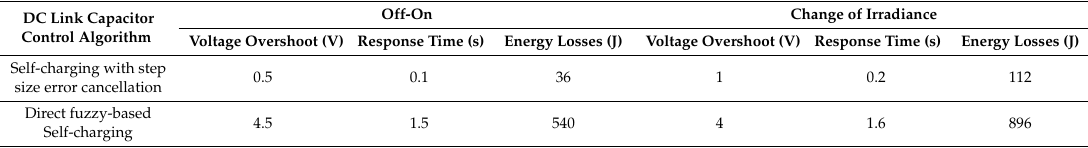
Table 4. Overall performance of DC link capacitor voltage control algorithms for both dynamic operations. DC Link Capacitor Control